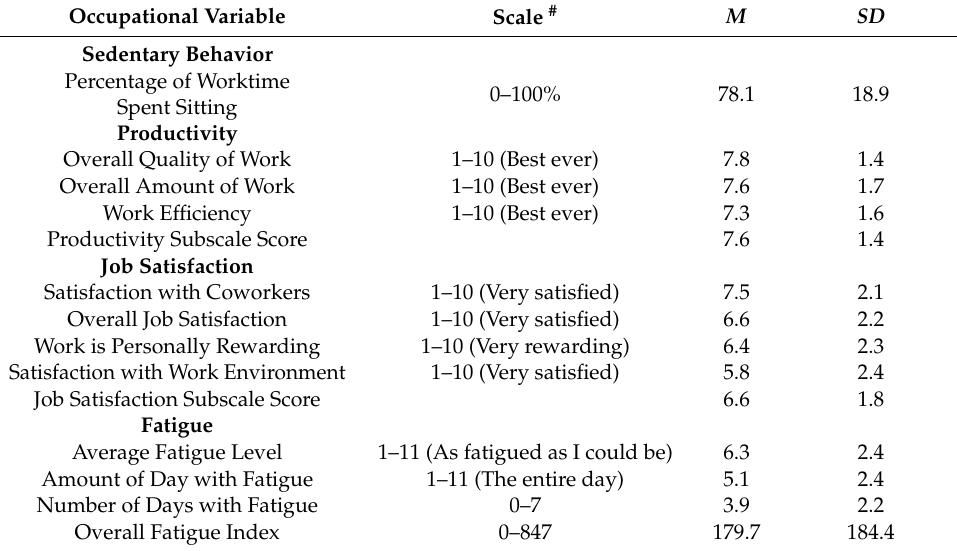
Table 3. Mean results for sedentary behavior, productivity, job satisfaction, and